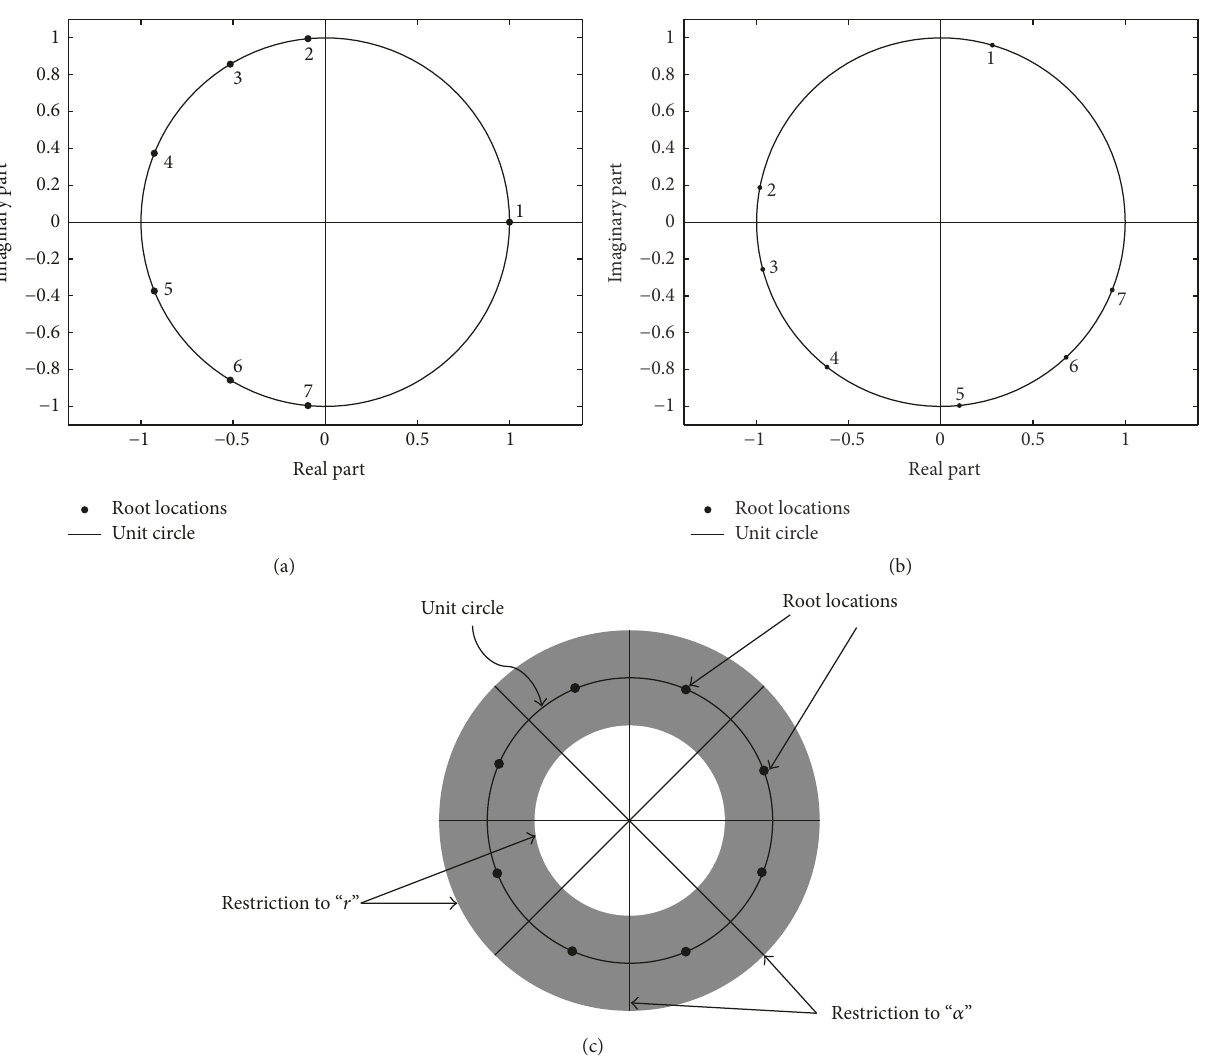
Figure 5: (a) The 𝑧 -space presentation of the Bayliss taper for SLL = − 30 dB. (b) Scanned pattern. (c) General solution space is divided with uniform